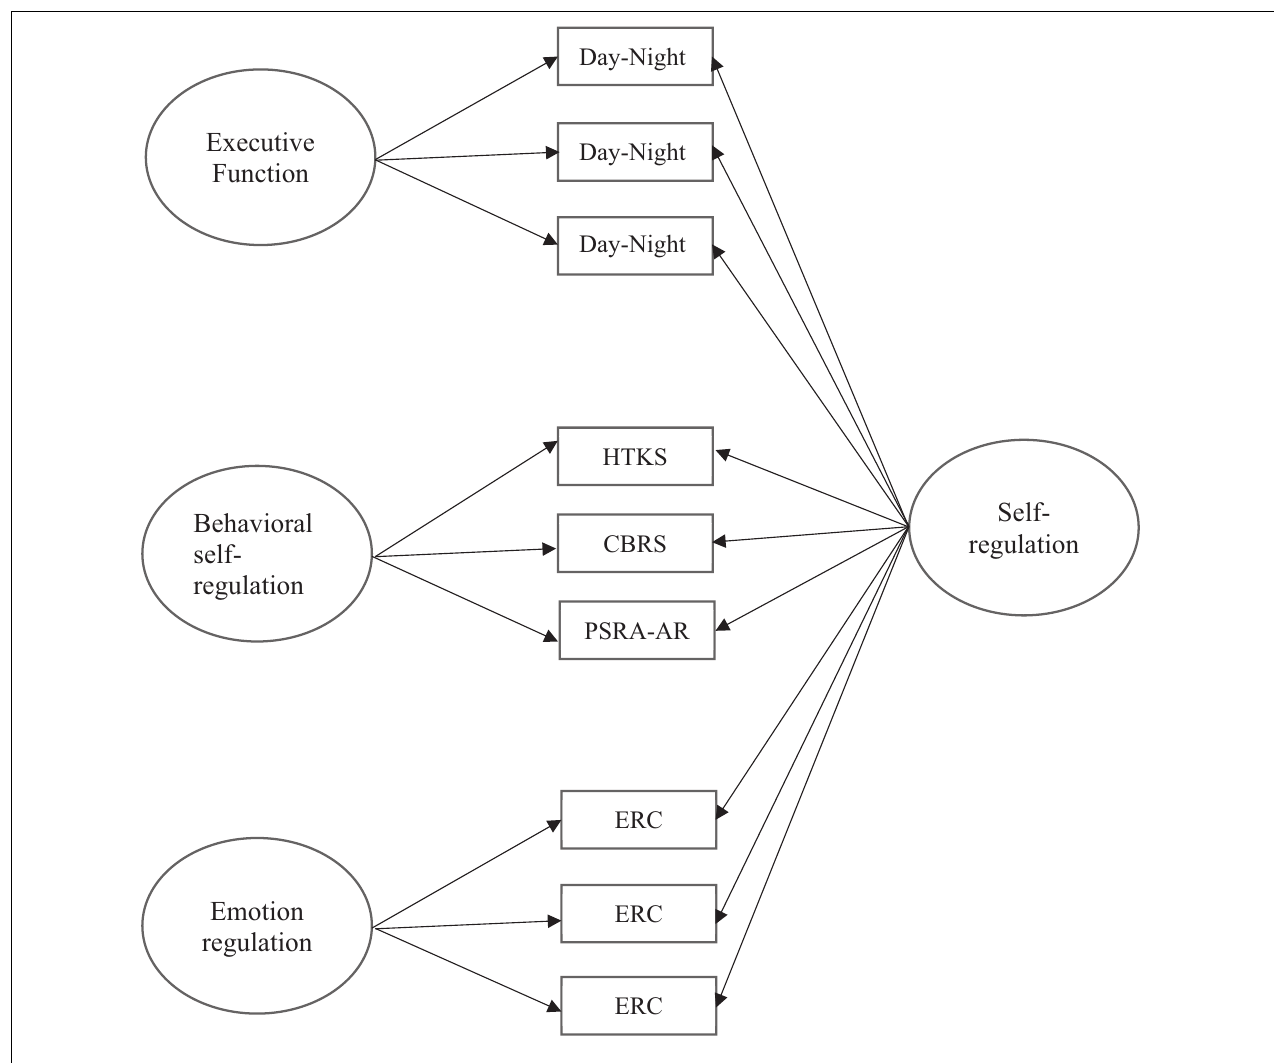
FIGURE 1 | Conceptual bifactor model